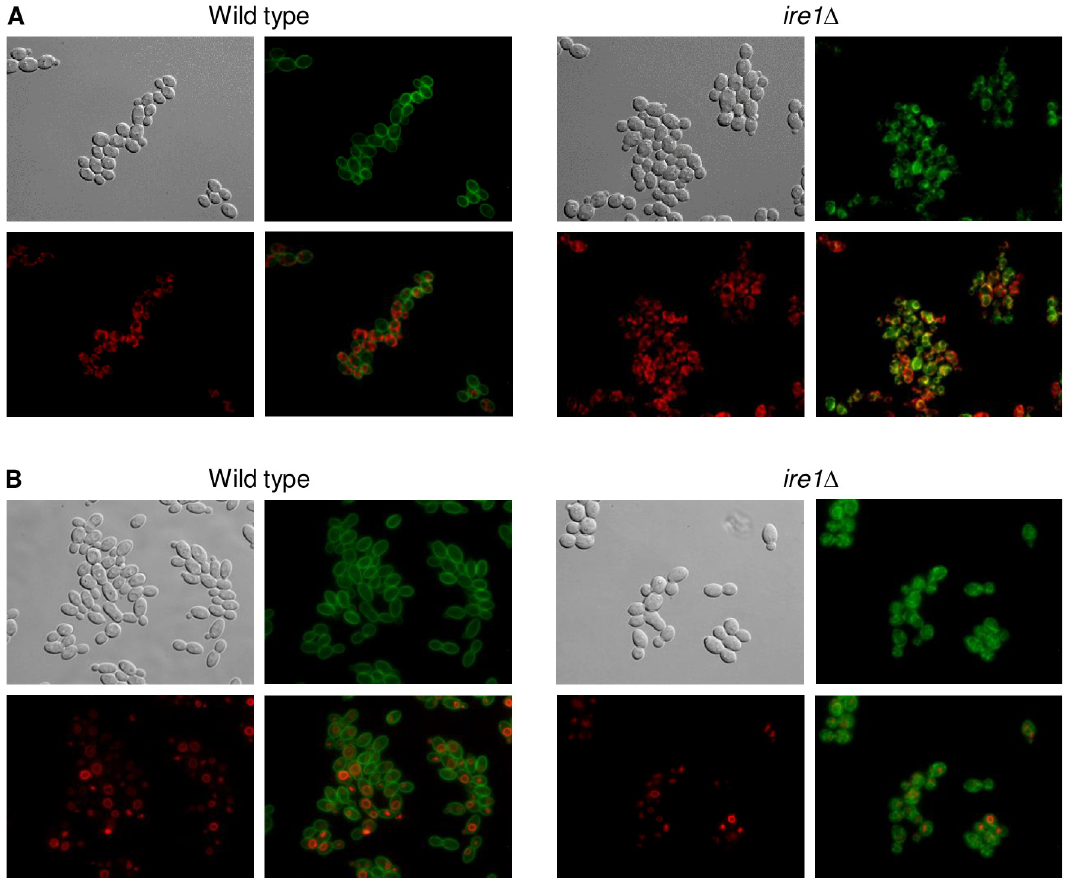
ER detection reagent (A) or FM4-64 (B), as described in Materials and methods. Cells were imaged by DIC and fluorescence microscopy using appropriate filters for green and red fluorescence. Shown are DIC images of the cells (top left panels), Ftr1-GFP (top right panels), ER or vacuole staining (bottom left panels), and merged images of Ftr1-GFP and ER/vacuole staining (bottom right panels). The two independently generated series of strains behaved identically and only one of them is